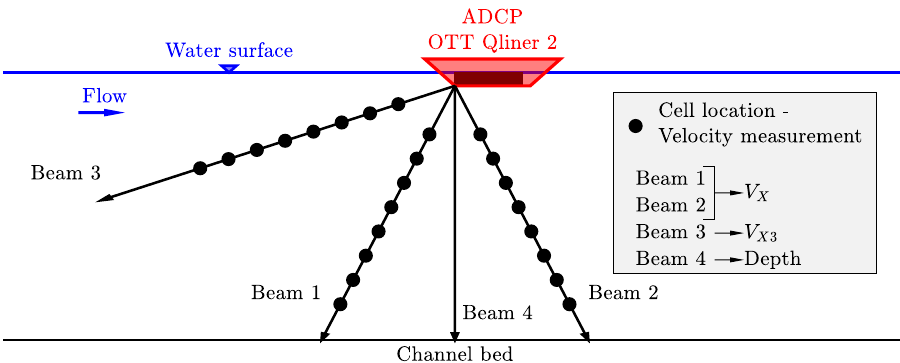
Figure 1. Overview of the measurement setup of the Ott Qliner